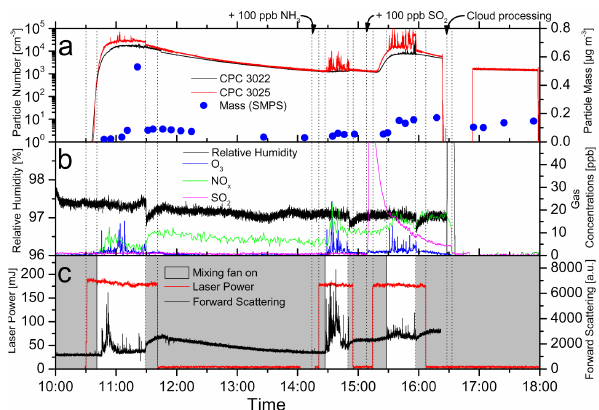
Fig. 6. Particle and trace gas formation by laser filaments in the synthetic air for experiments 5 and 8 at 283K and 97% RH. The panels show (a) particle number (red and black line) and mass (blue circles); (b) relative humidity (black line), ozone (blue line), NO x (green line), and SO 2 concentrations (magenta line); (c) near- forward scattering (black line), laser power (red line) and mixing fan operation (grey shaded area).